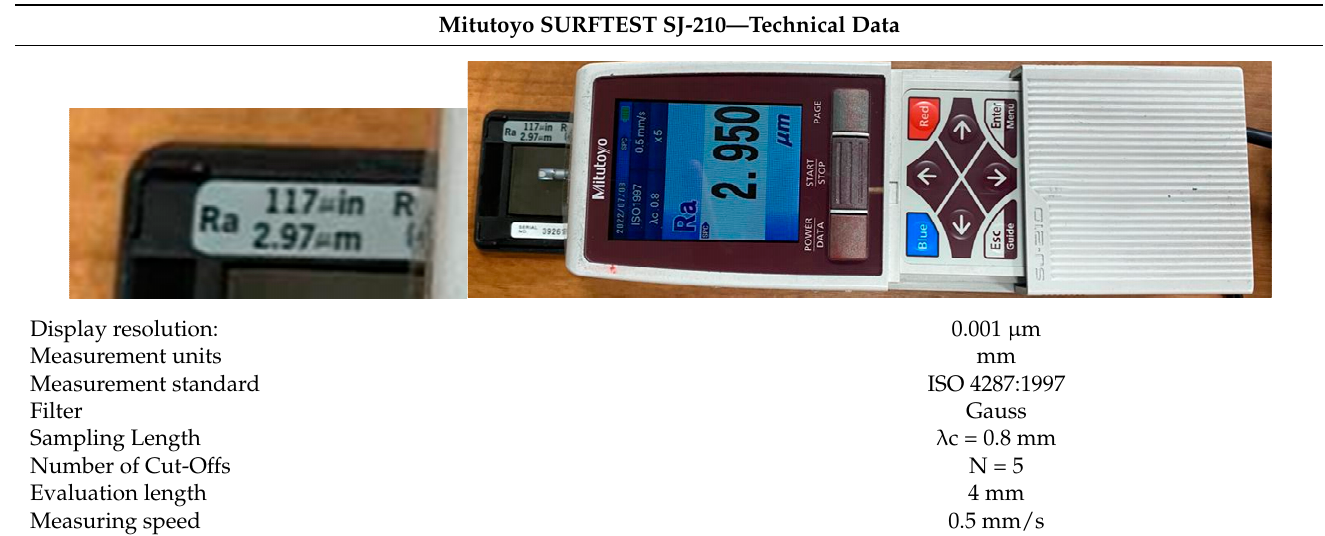
Table 3. Features of the Mitutoyo SURFTEST SJ-210 surf test.